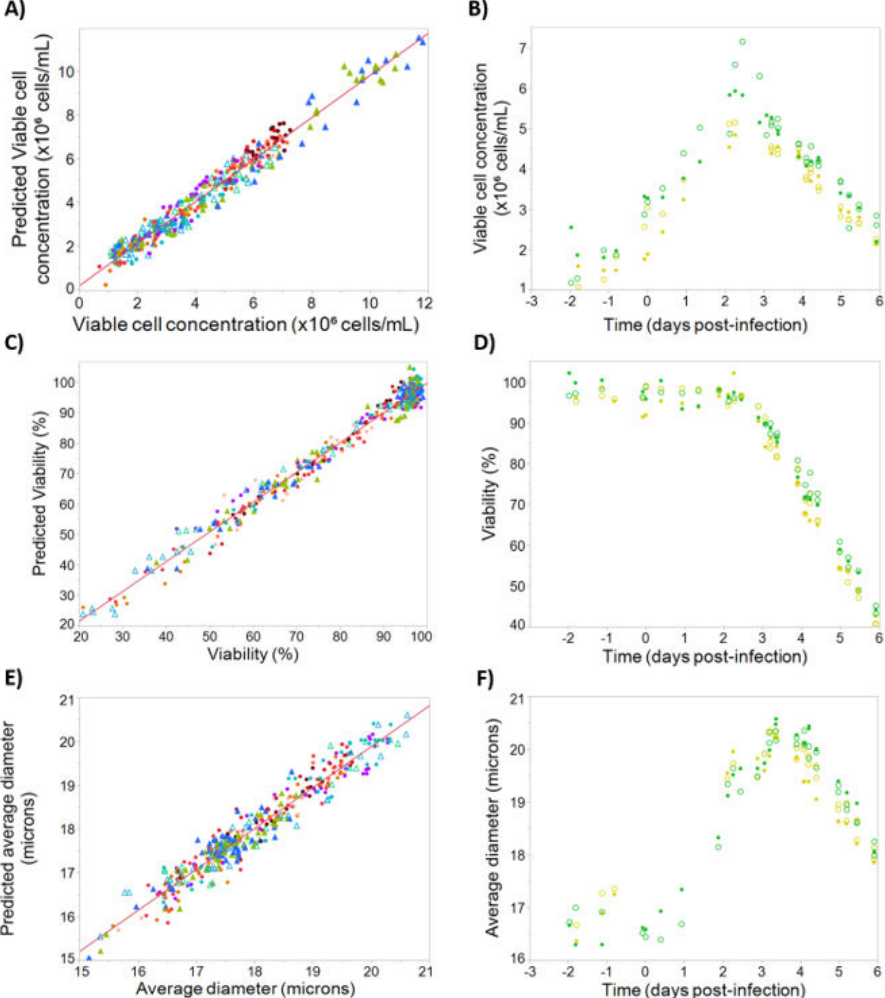
Figure 5. Calibration and testing data for viable cell concentration, viability, and average cell diameter. On the left, observed and predicted values for the calibration dataset, for ( A ) viable cell concentration, R 2 = 0.96; ( C ) viability, R 2 = 0.98; ( E ) diameter, R 2 = 0.94. Batches are represented by di ff erent colors, with filled triangles representing “cell density e ff ect” batches, empty triangles representing “empty” batches, and filled circles representing “standard” and “blend” batches. On the right, time-course profiles for the testing set, for ( B ) viable cell concentration, Q 2 = 0.89; ( D ) viability (Q 2 = 0.97); ( F ) diameter (Q 2 = 0.92). Batches are represented by di ff erent colors, with reference data shown as open circles and corresponding model-predicted values shown as filled